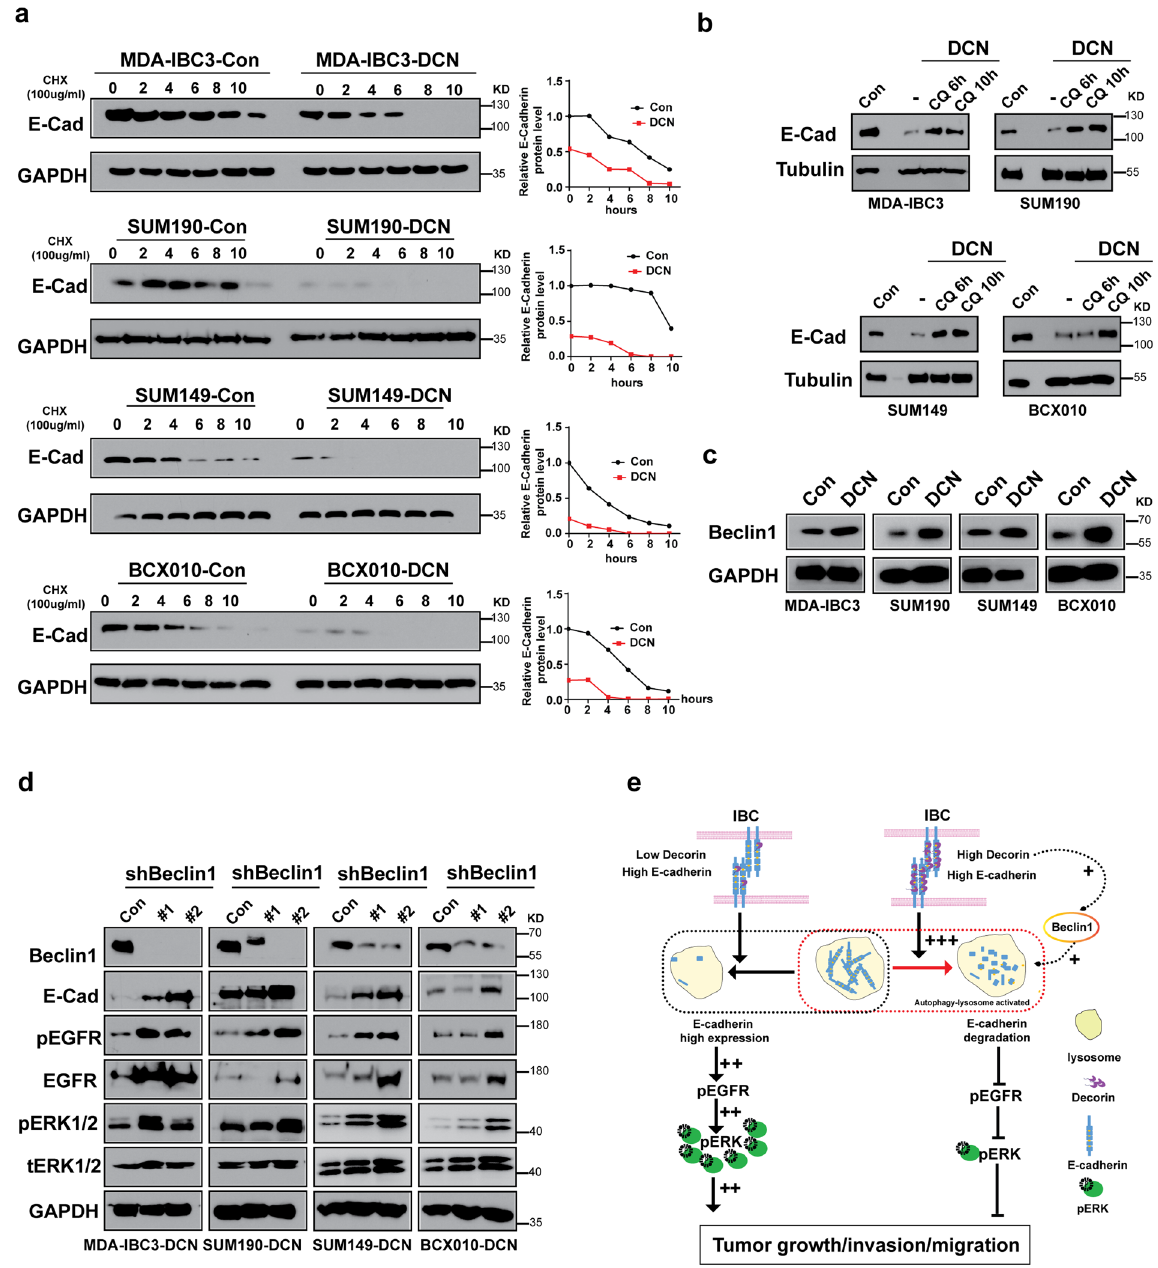
Fig. 6 DCN modulates the stability of E-cadherin protein through an autophagy-linked lysosomal pathway. a DCN destabilizes E-cadherin protein in IBC cells. DCN-overexpressing and control IBC cells were treated with the protein synthesis inhibitor cycloheximide (CHX, 100 μ g/mL) at 0, 2, 4, 6, 8, or 10 h was shown. Total cell lysates were subjected to western blotting analysis with the indicated antibodies. GAPDH served as a loading control. b the lysosomal inhibitor chloroquine (CQ) markedly delayed the DCN-induced degradation of E-Cadherin. DCN-overexpressing IBC cells were treated with 20 μ M CQ for 6 or 10 h, and total cell lysates were subjected to western blotting analysis with the indicated antibodies. GAPDH served as a loading control. c Overexpression of DCN promotes Beclin1expression in IBC cells. Total cell lysates were subjected to immunoblotting with the indicated antibody. GAPDH served as a loading control. d DCN inhibition of E-cadherin expression and EGFR pathway activation in IBC cells is dependent on Beclin1. DCN- overexpressing cells were transduced with two independent lentiviral Beclin1 shRNAs or control shRNA; 48 h later, the cells were harvested and analyzed by western blotting with the indicated antibodies. GAPDH was used as a loading control. Beclin1 knockdown resulted in elevation of E-cadherin expression and EGFR pathway activation in DCN-overexpressing IBC cells. e Proposed model summarizing the DCN-mediated inhibition of tumorigenesis and metastasis in IBC cells through a mechanism involving the lysosomal degradation of E-cadherin and suppression of the EGFR – ERK signaling cells 59 – 61 . Analysis of an IBC patient dataset that contains both IBC tumor cells and tumor stroma (GSE5847) con fi rms that DCN is expressed in both tumor cells and stroma, with slightly have shown that DCN expression is very low in IBC tumors and